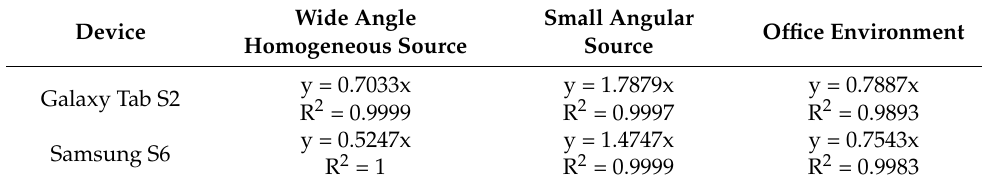
Table 1. Slope values and regression coefficients with each device in each of the conditions a table.